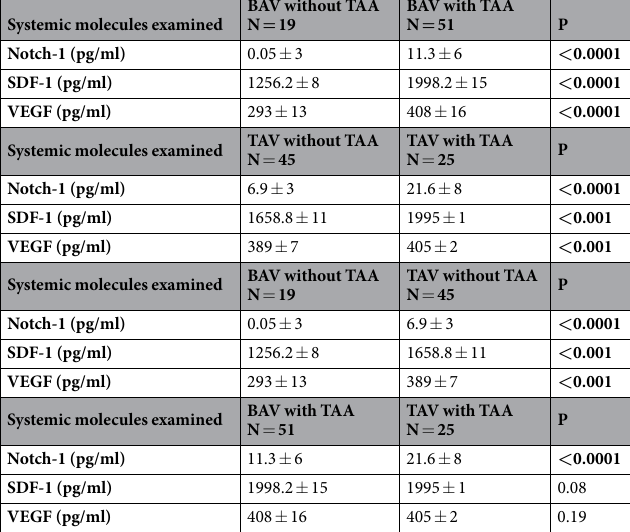
Table 2. Systemic plasma levels of Notch1, SDF-1, and VEGF. Vascular endothelial growth factor (VEGF), Stromal cell-derived factor- (SDF)-1 . * By unpaired t-test with Welch correction .